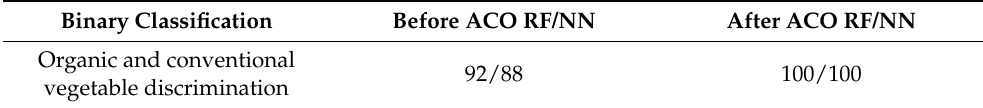
Table 7. Comparison of ACO